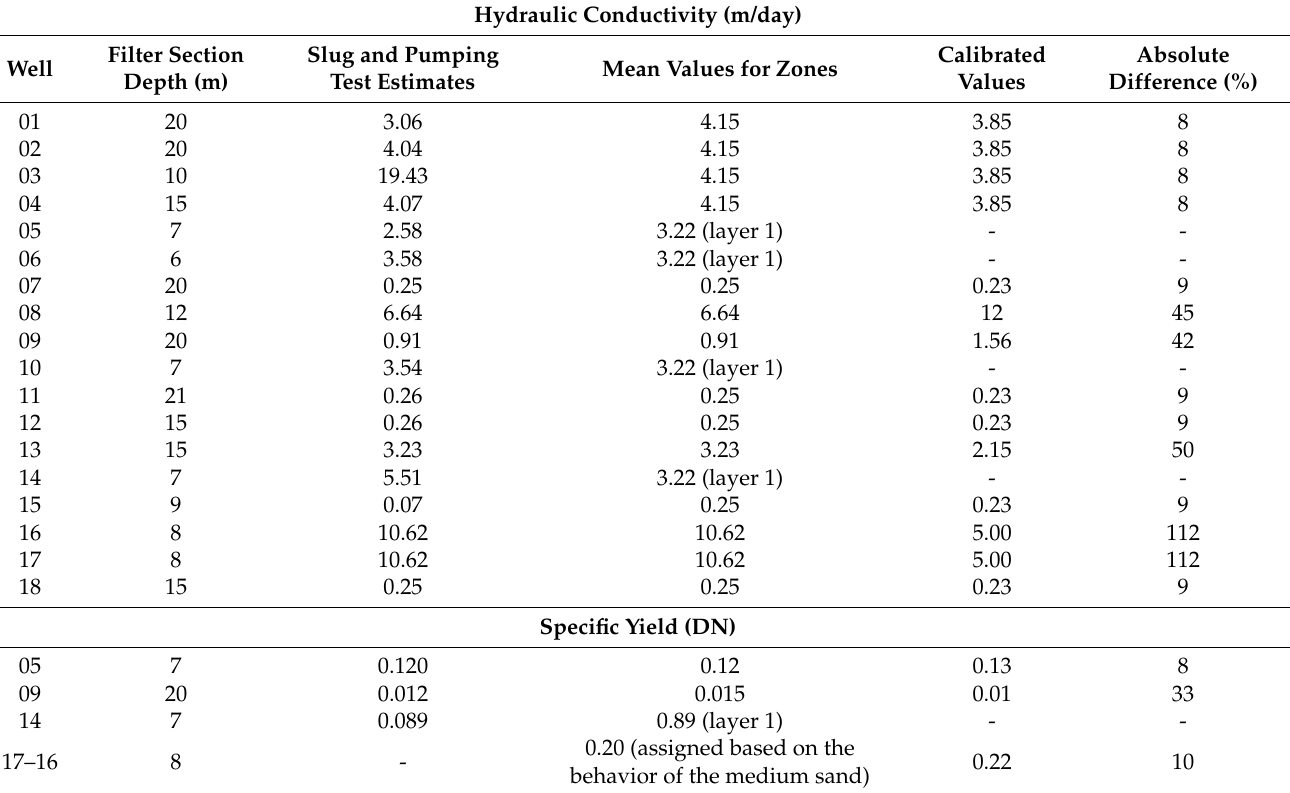
Figure 5. Spatial distribution of the numerical model parameters Ksat (saturated hydraulic conductivity) and Sy (specific yield coefficient). ( A , C ) Average values of point slug and pumping tests estimates for the first layer; ( B , D ) calibrated values for the second layer. Table 2. Ksat and Sy for punctual field estimates and calibrated zones